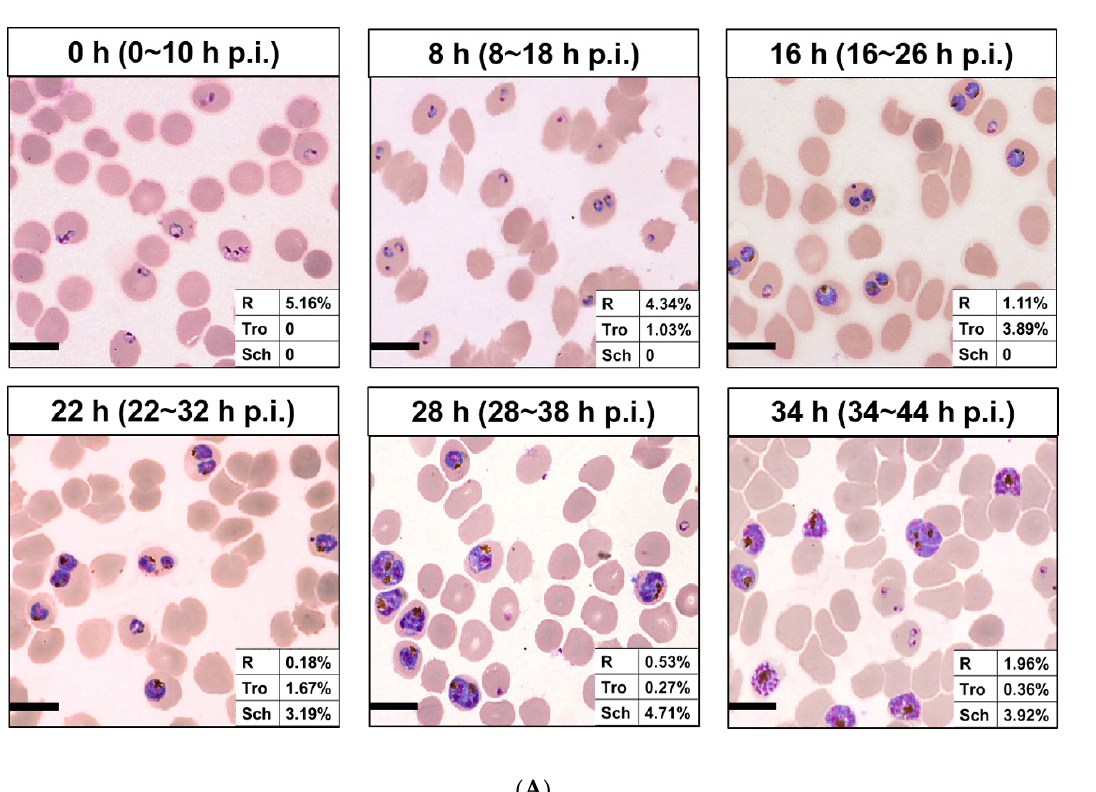
Figure 2. Optimization of permeability of the P. falciparum -infected erythrocytes with non-synchro- nized culture. Three factors are involved, including ( A ) concentration: 25, 50 and 100 µg/mL; ( B ) temperature: 4 °C, 25 °C and 37 °C, ( C ) incubation time: 1 h and 3 h. One factor was tested with the optimal conditions of other two factors. x -axis indicates incubation condition, y -axis indicates bind- ing rate. The data below this chart showed specific binding rate of nanomaterials.